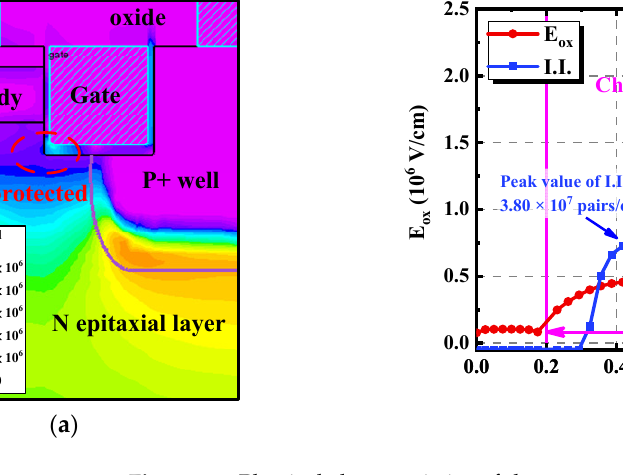
Figure 11. Physical characteristics of the asymmetric trench SiC MOSFET with a vertical channel under the avalanche state. ( a ) Distribution of the electric field. ( b ) Extracted E ox and I.I. along the gate oxide interface.